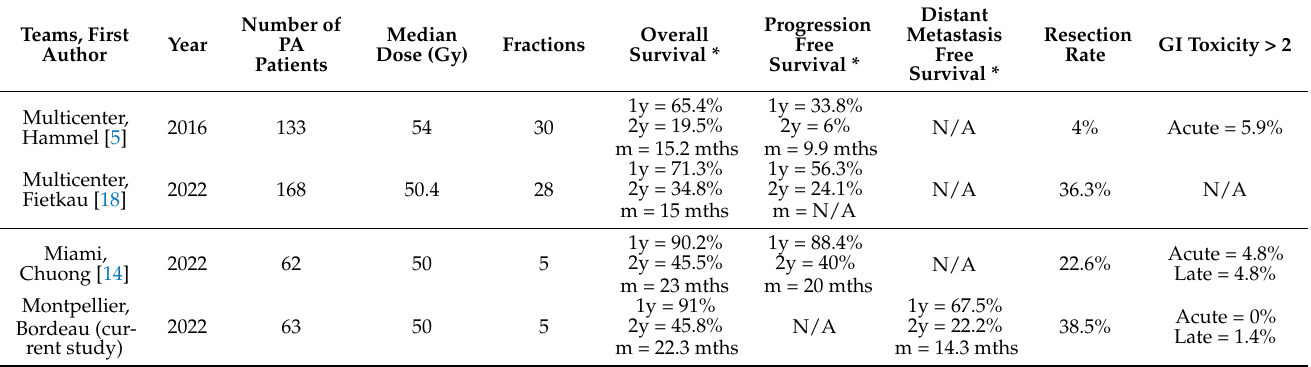
Table 6. Comparison of studies, including radiotherapy for advanced pancreatic adenocarcinoma: radiotherapy arm of the studies LAP07 and CONKO-007 including fractionated chemoradiotherapy and chemotherapy (above the line) versus studies including SMART after induction chemotherapy (below the